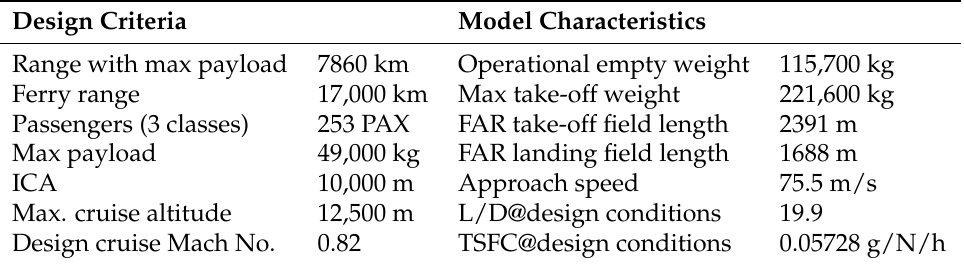
Table 3. Top level design requirements for the reference aircraft A330-200 and its model characteristics. PAX: passenger; FAR: federal aviation regulation; L/D: lift-to-drag ratio; TSFC: the specific fuel consumption.